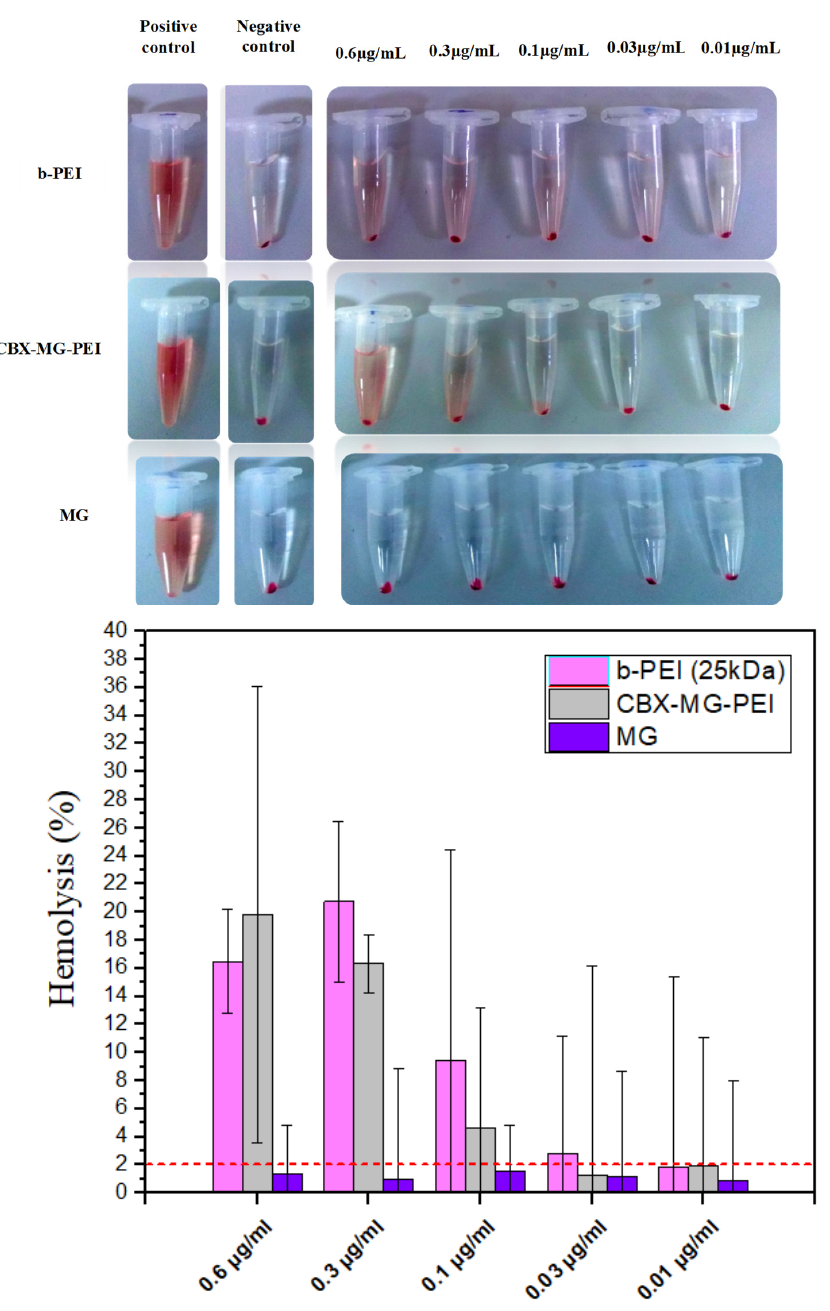
Figure 6. Hemolysis assay results obtained for b-PEI, CBX-MG-PEI, and MG.